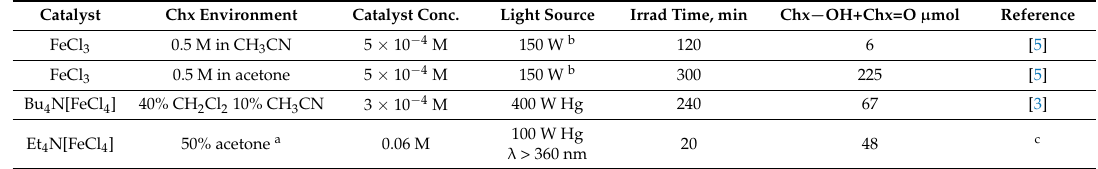
Table 8. Comparison of yield of oxygenated products from the homogeneously catalyzed photooxidation of cyclohexane diluted in another solvent.